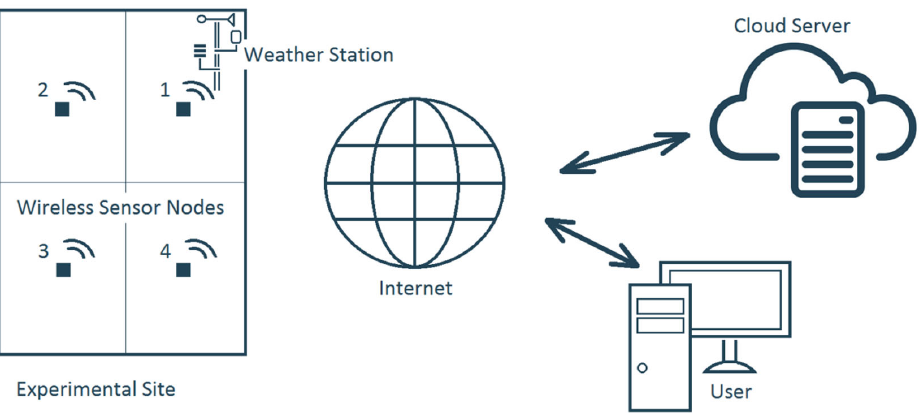
Figure 1. Overall view of wireless sensor network (WSN).